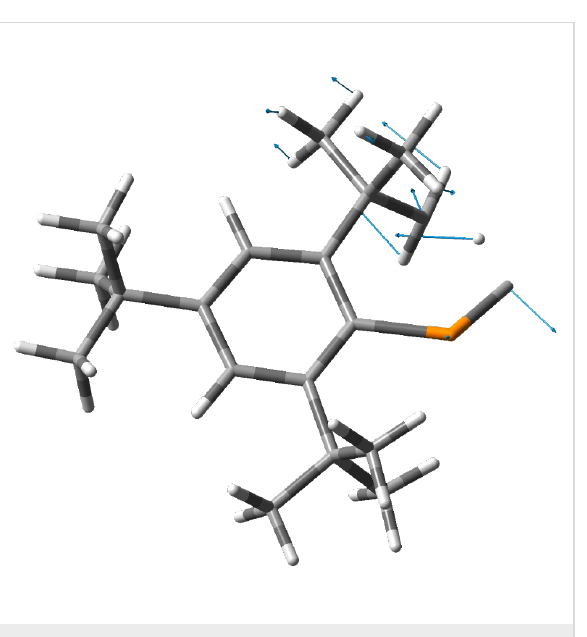
Figure 3: Displacement vectors of the transition state ( ν = 216.93 i cm –1 ).